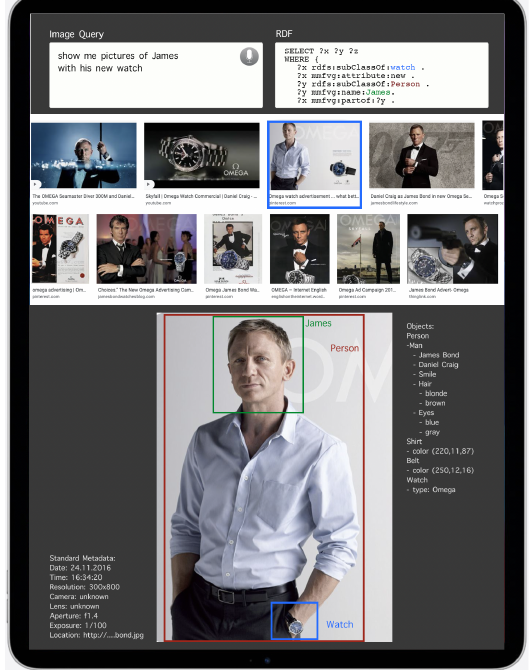
Figure 15. The Swift prototype design for GMAF, MMFVG and graph